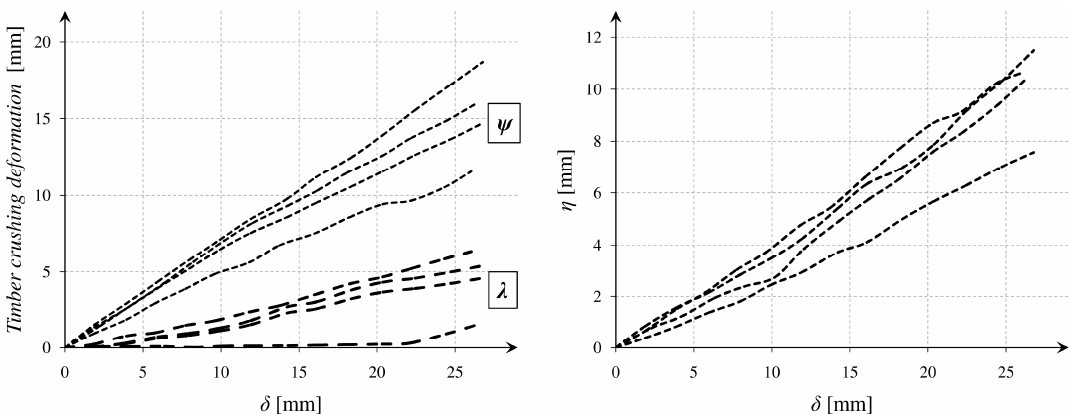
Figure 4. Digital image correlation (DIC) method and δ , λ , ψ , η parameters determination.